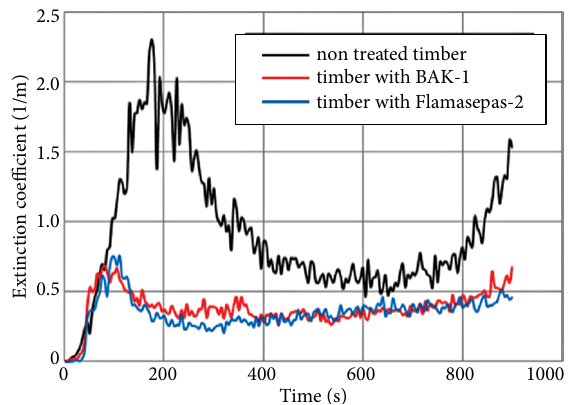
Fig. 12. The extinction coefficient obtained during the combustion of non-treated and treated specimens in the cone calorimeter at the heat flux of 30 kW/m 2 (without piloted